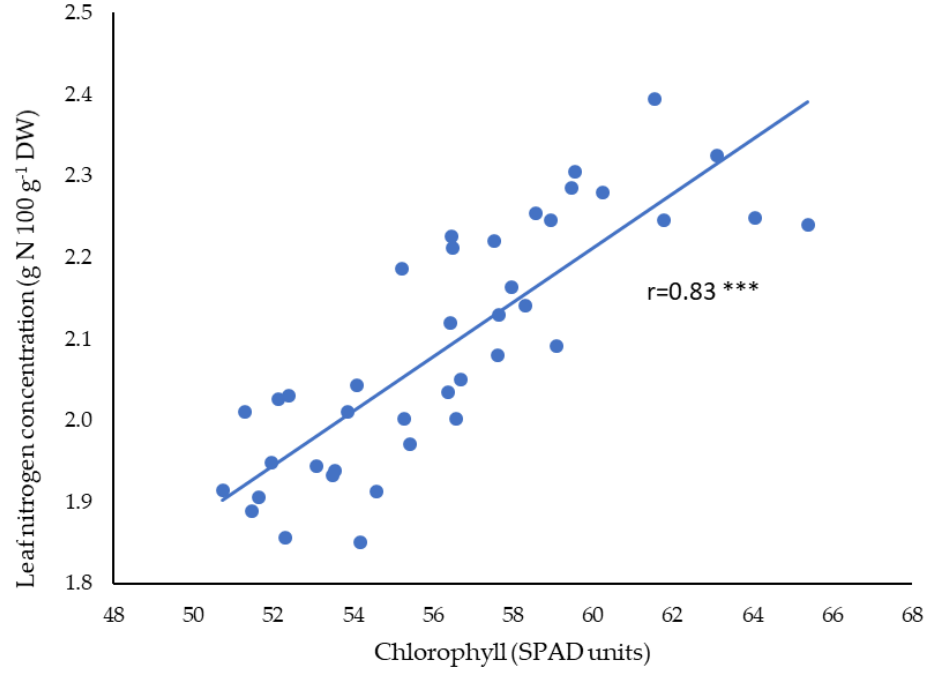
Figure 2. Correlation between SPAD readings and nitrogen concentrations of the leaves collected in summer from mature Kaki Tipo and Rojo Brillante persimmon orchards. For each cultivar, each point represents the mean of 4 trees selected in 5 different farms; r = Pearson correlation coefficient. ***: significant for p ≤ 0.001.